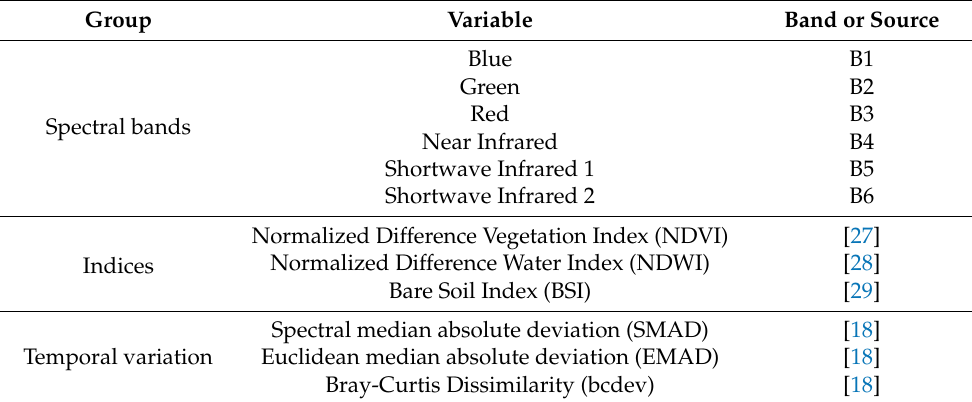
Table 2. Variables used for irrigated land use classification for the Ord River Irrigation Area site. Group Variable Band or Source Blue B1 Green B2 Red B3 Spectral bands Near Infrared B4 Shortwave Infrared 1 B5 Shortwave Infrared 2 B6 Normalized Difference Vegetation Index (NDVI) [27] Normalized Difference Water Index (NDWI) [28] Indices Bare Soil Index (BSI) [29] Spectral median absolute deviation (SMAD) Temporal variation Euclidean median absolute deviation (EMAD) Bray-Curtis Dissimilarity